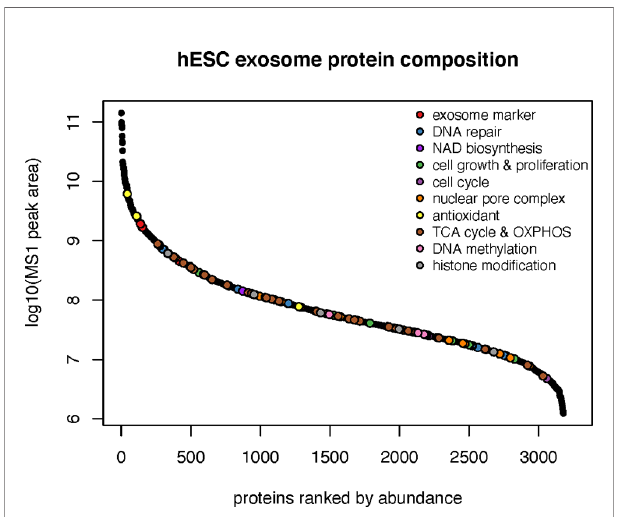
FIGURE 3 | Protein classes present within hESC-derived EV. Relative abundance of the 10 major classes of proteins identi fi ed by proteomic analysis of hESC-derived EV.